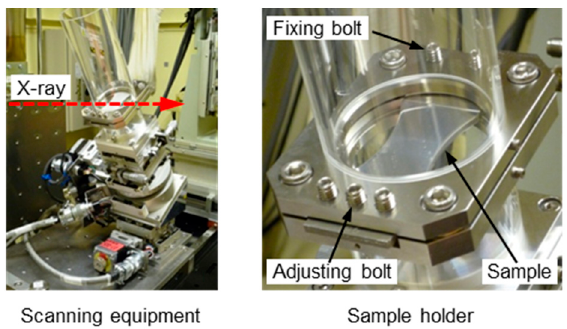
Figure 11. The scanning equipment of SR-based CL and the sample holder.